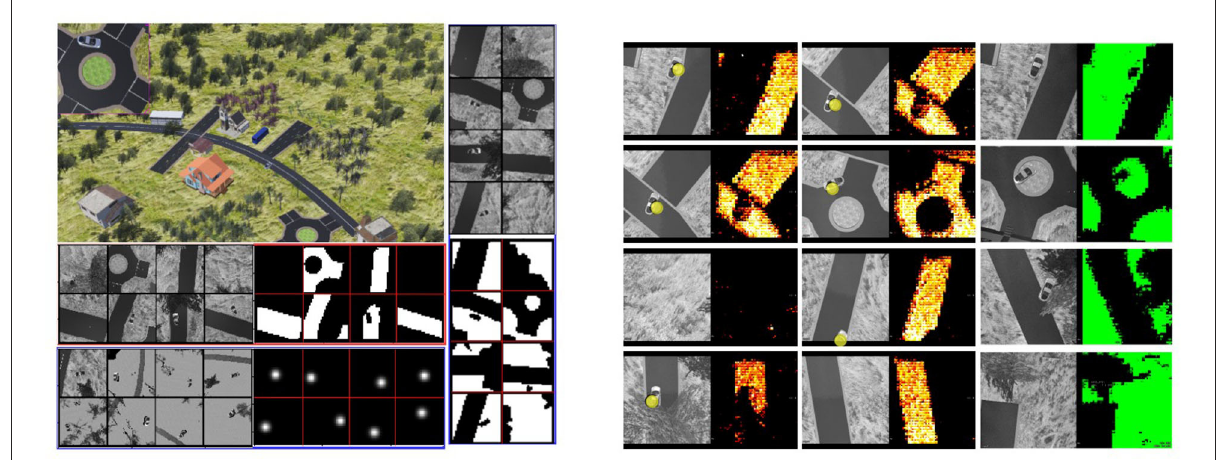
FIGURE13 Data collection environment and inference results. Left) The data collection environment where a vehicle is moving around and images are generated from a bird’s eye view of a simulated drone; top left: A robot simulator for environment setup and collection of training data; middle left: The collected images from the drone’s camera are converted into gray-scale images for the real PPA and the segmentation annotations of the road. Right) The training and annotated datasets for grass segmentation; bottom left: this study uses the Gaussian distribution to represent the vehicle position within an image; right: FCN inference results on-sensor. The left column is the input gray-scale image on the sensor with yellow dots indicating the FCN inference localization prediction and the right column is the inference results for coarse segmentation on the sensor. The density and distribution of colorful points (right) represent the possibility of the position of the road (bright yellow) and grass (green) segmentation. The experimental performance for localization (accuracy) and segmentation (IoU) on the PPA can be seen in Figure 14. An example video can be seen at